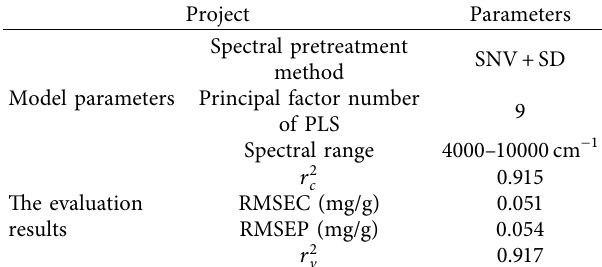
Table 6: The parameters of the optimal NIR detection model.